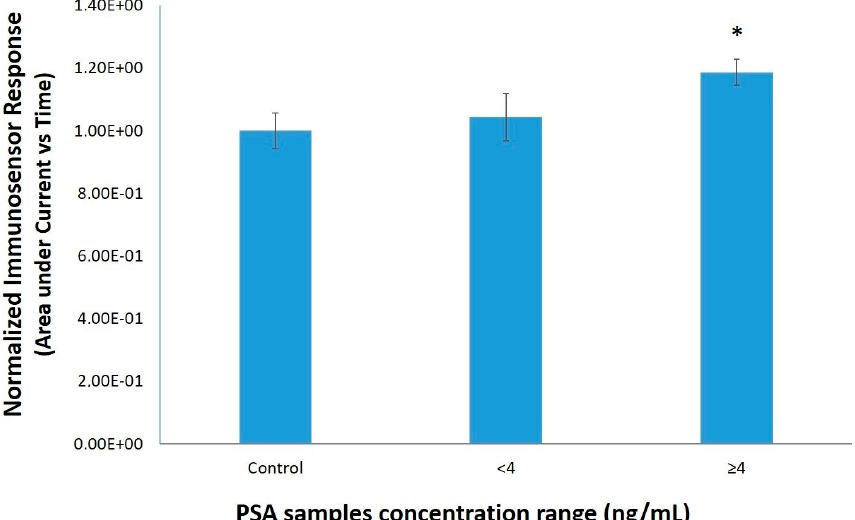
Figure 5. Normalized biosensor response (area under current vs. time) against 39 human serum samples classified in three different PSA concentration ranges (0, <4 ng/mL and ≥ 4 ng/mL). Data are means ± SE of replications (n = 24) received on three different dates using different batches of immunosensors. * p < 0.05, significantly different from control samples with a PSA concentration ≥ 4 ng/mL.